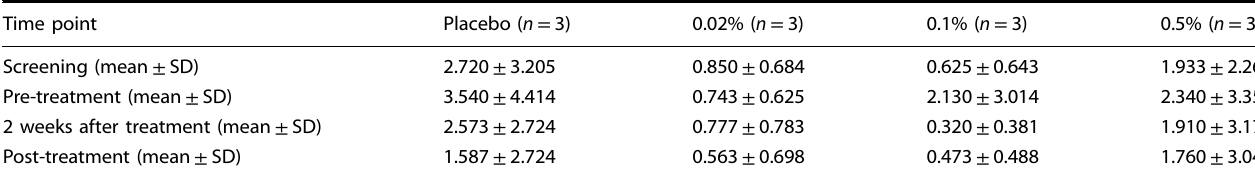
Table 2. Skin ulcer size